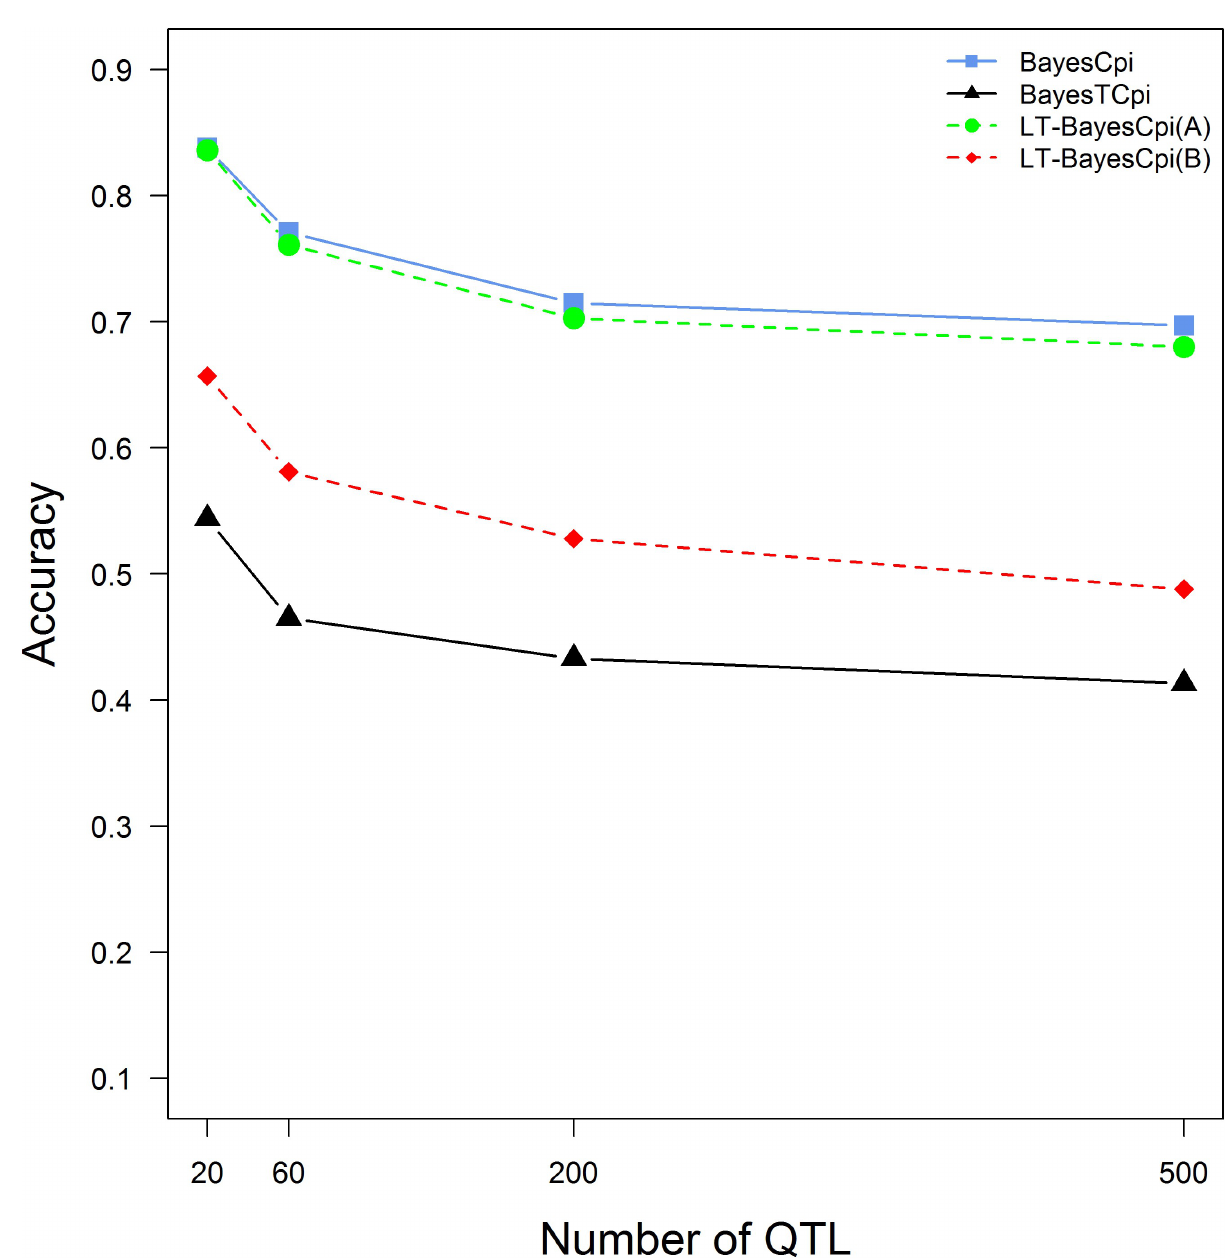
Fig 2. Accuracies of GEBVs from three methods in generation 3 when the number of simulated true QTL changed from 20 to 500.